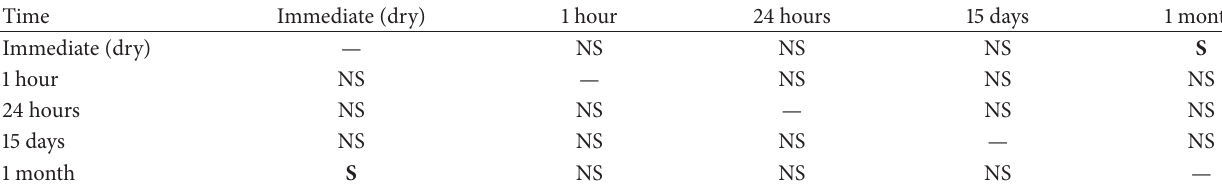
Table 3: Post hoc Tukey’s test for Group III (Power “O”